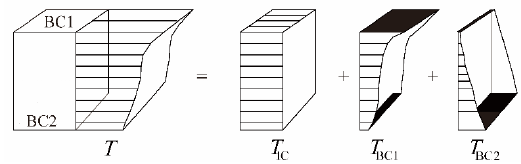
Figure 8. Temperature decomposition of concrete slab.